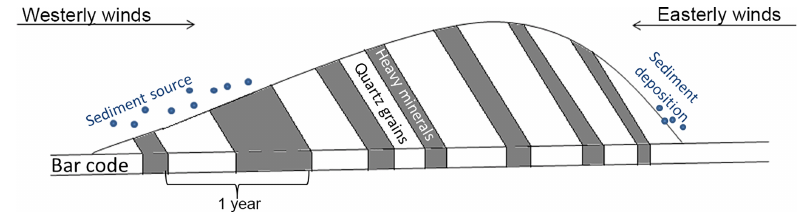
Figure 1. Schematic representation of the Łeba dune structure (adapted from Ludwig et al.,